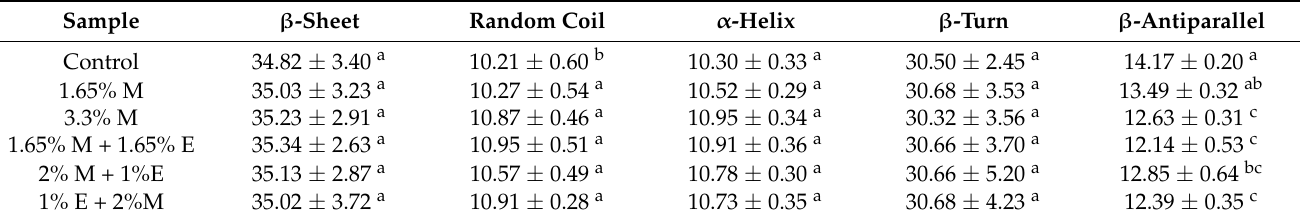
Table 3. Secondary structure percentage (%) analysis of different maltitol and erythritol content gel by analyzing the areas of 1600–1700 cm − 1 in FTIR